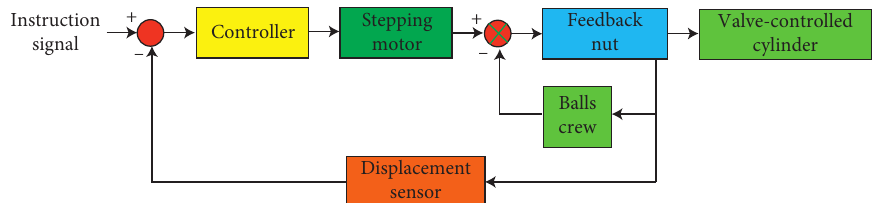
Figure 1: Schematic diagram of a digital hydraulic cylinder